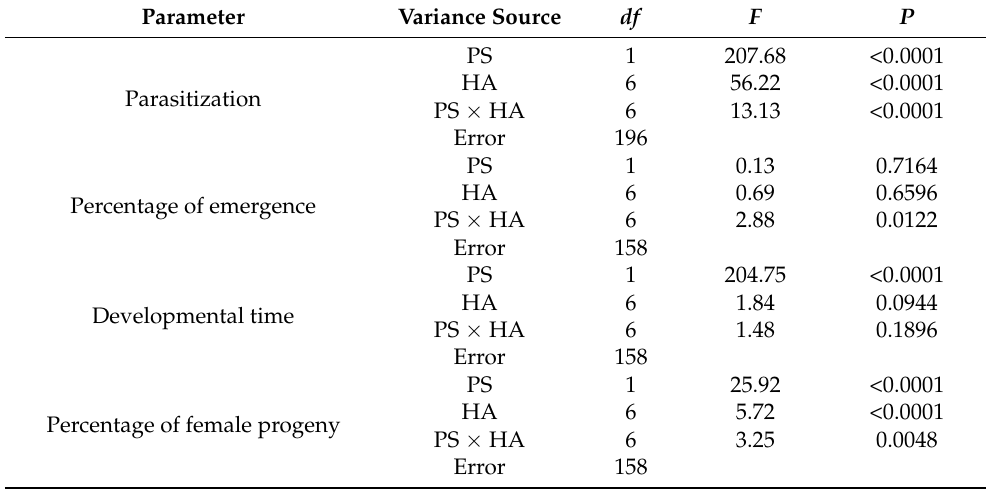
Table 1. Results of two-way ANOVA testing the effects of parasitoid species (PS), host ages (HA), and their interactions on the performance of Trichogramma dendrolimi and Trichogramma ostriniae in terms of parasitization, parasitoid emergence, development, and female